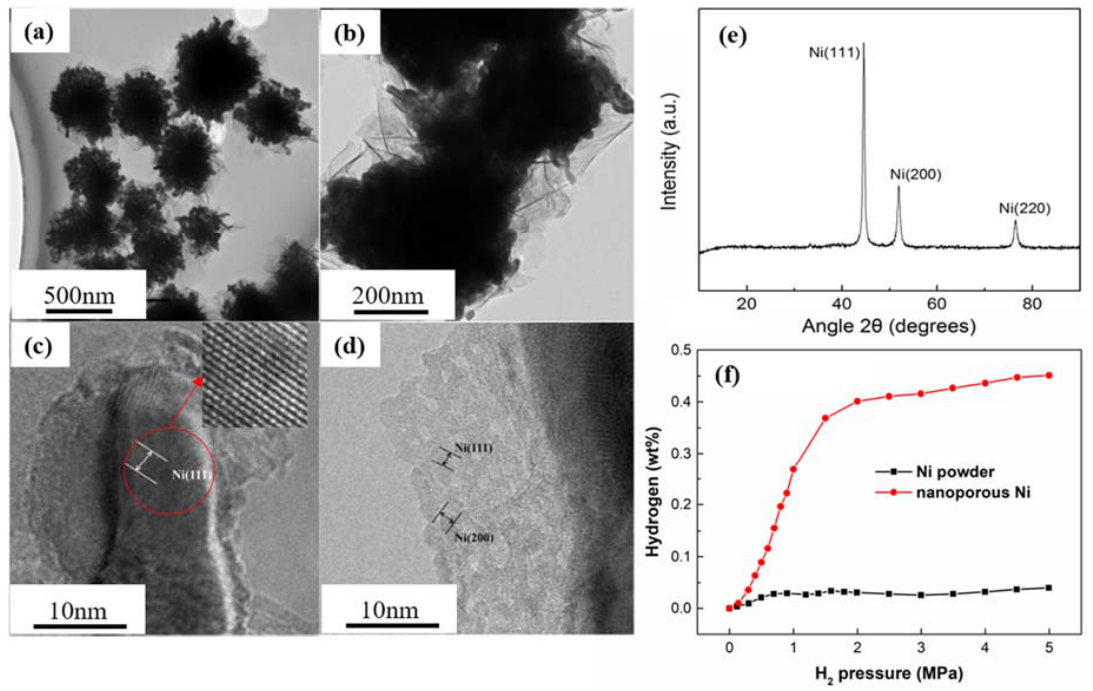
Figure 6. TEM ( a , b ), HRTEM ( c , d ) images and XRD pattern ( e ) for nanoporous Ni with the plating time of 6 times at 35 °C; ( f ) hydrogen adsorption curves for the nanoporous Ni and Ni powder at room temperature.